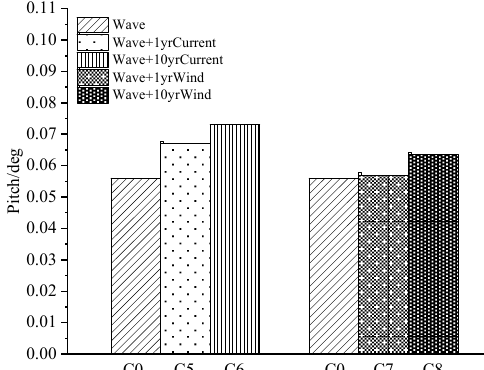
Figure 22. RMS for pitch responses.